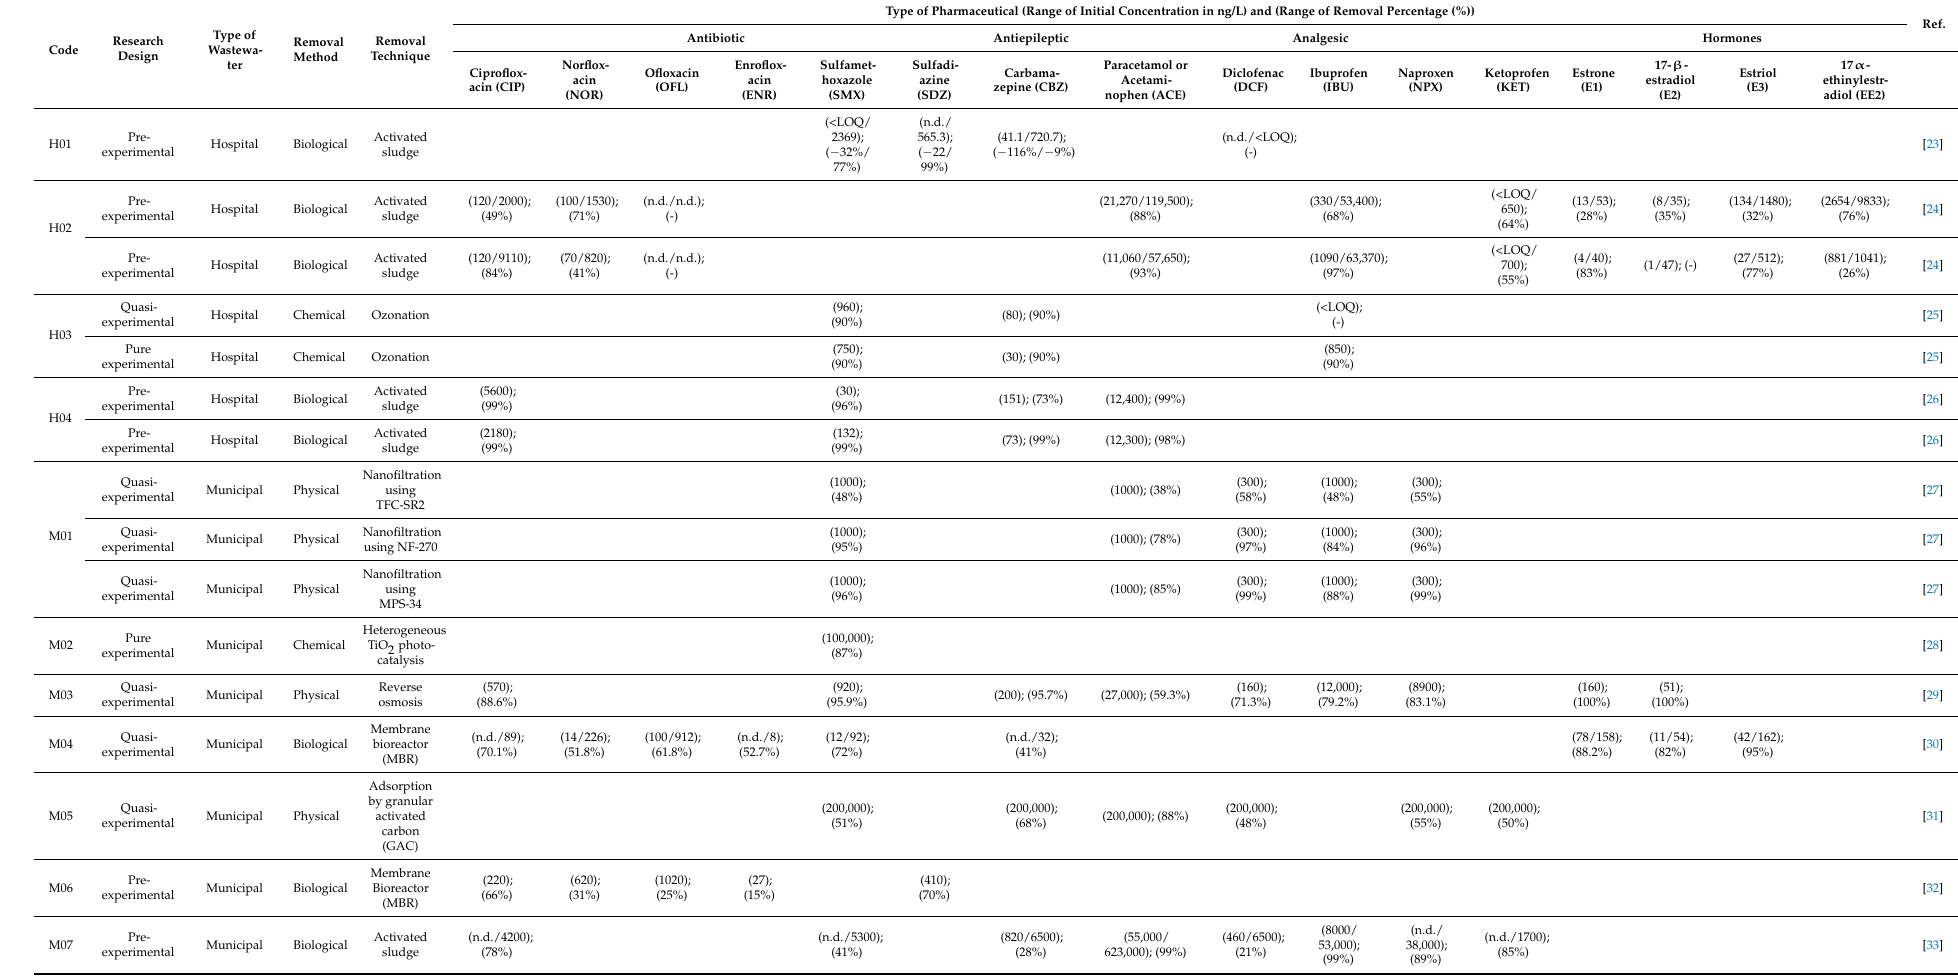
Table 1. Data collection